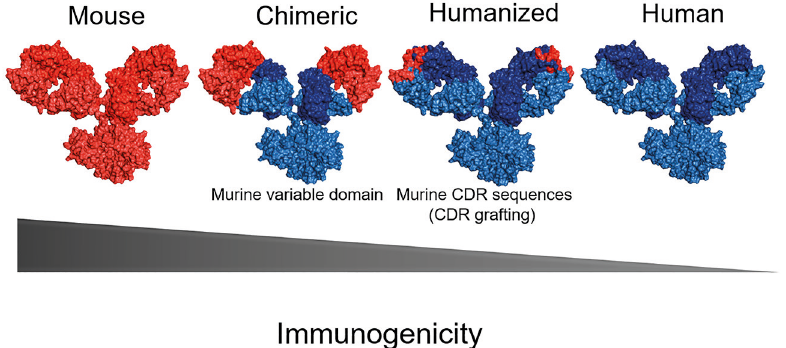
FIGURE 1 – Schematic overview of antibody humanization from murine antibodies (red domains) to fully human antibodies (blue domains). Chimeric antibodies are produced by combining sequences of a murine variable domain with human constant region domains. The murine CDR sequences transplanted to a human framework sequence produce humanized antibodies by the technique known as CDR grafting. Fully human antibodies are expected to be less immunogenic than chimeric and humanized antibodies. The images of the immunoglobulin structure (PDB code 1IGY) were created using PYMOL (The PyMOL Molecular Graphics System, Version 2.0 Schrödinger,